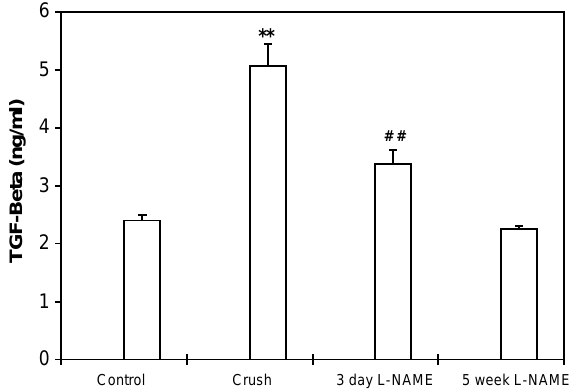
FIG. 1. TGF- b concentrations in tendon organ cultures from control uninjured rat paws, crush-injured rat paws (3 days after injury) and crush-injured rat paws with L-NAME treat- ment (3 days and 5 weeks after injury). Error bars represent standard error of the means. **p B / 0.005 versus control uninjured paws, and ## p B / 0.01 versus 3-day crush-injured